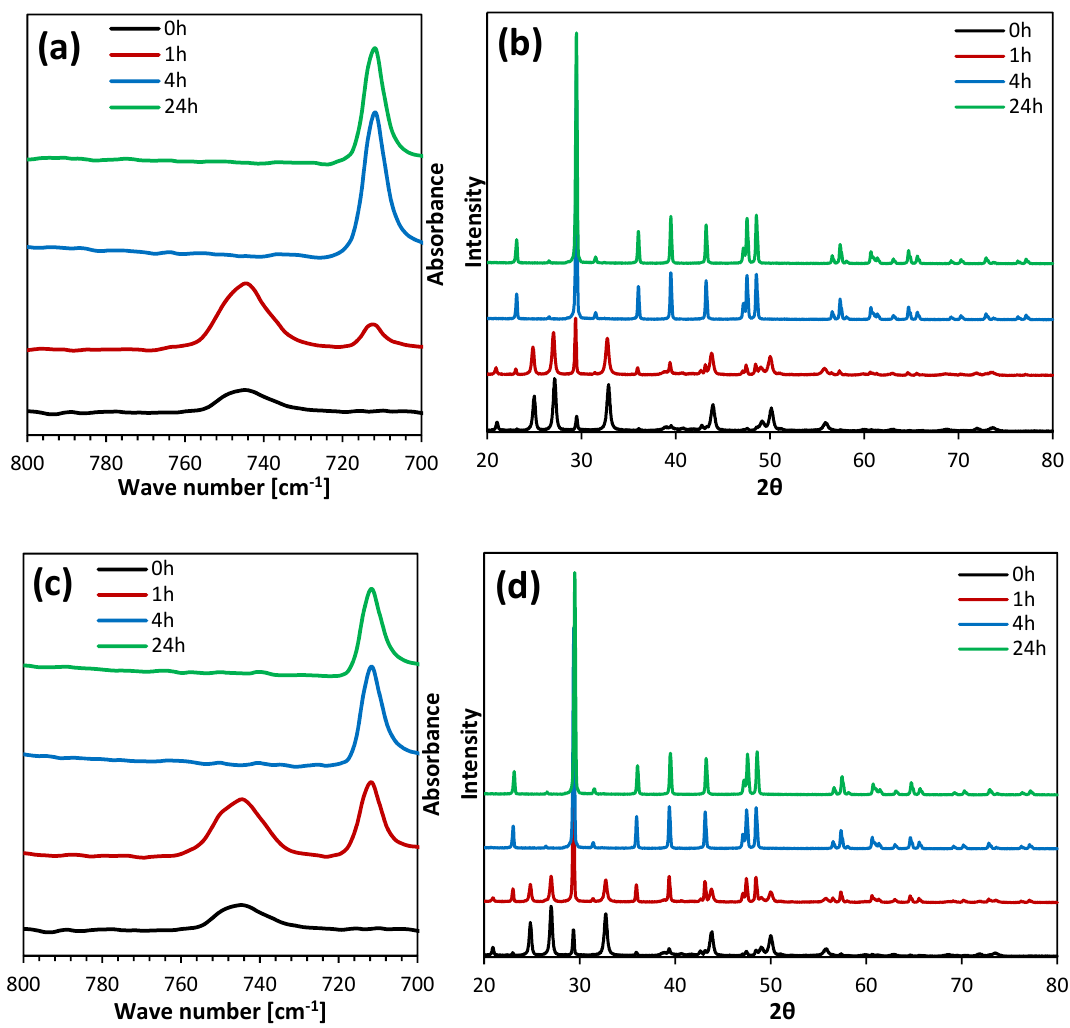
Figure 2. FTIR spectra and XRD patterns of CaCO 3 precipitated from pure water ( a , b ) and from a mixture containing 15% ( v / v ) of methanol ( c , d ) .